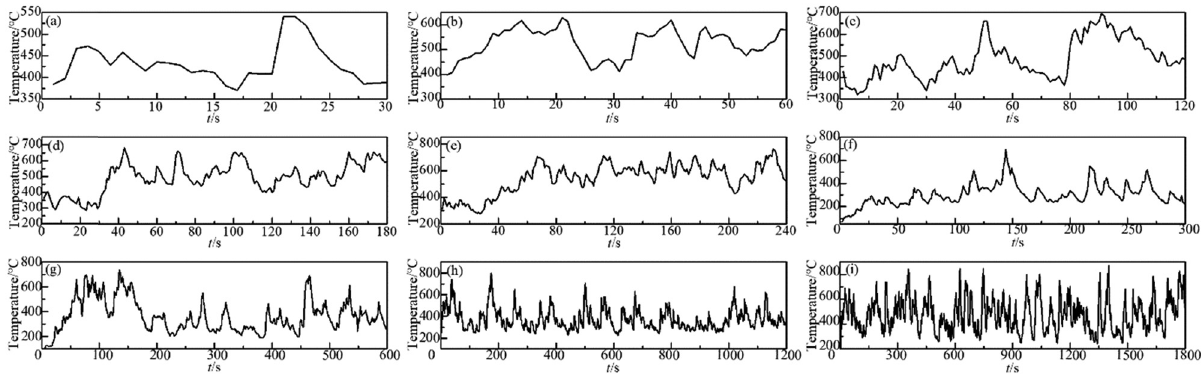
Figure 2: Temperature curve of oxidation for ( a ) 0.5 min, ( b ) 1 min, ( c ) 2 min, ( d ) 3 min, ( d ) 4 min, ( e ) 5 min, ( f ) 10 min, ( h ) 20 min, and ( i ) 30